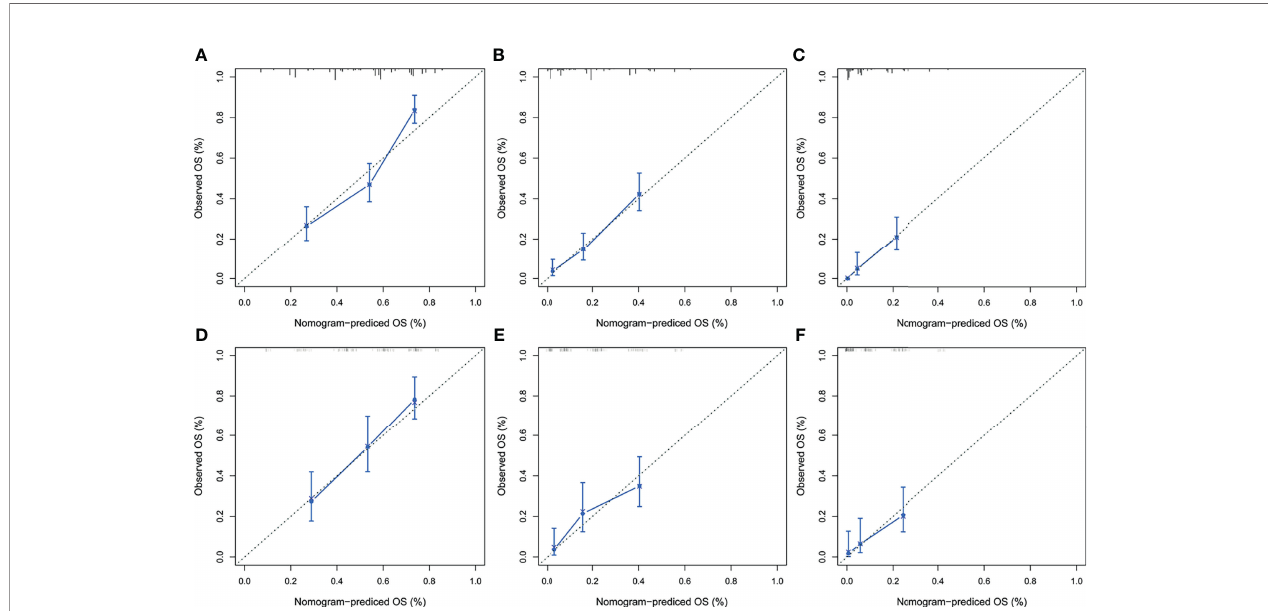
FIGURE 8 | The calibration curves of the prognostic nomogram for predicting 1-year (A) , 3-year (B) , and 5-year (C) OS in the training set. Calibration curves of the prognostic nomogram for predicting 1-year (D) , 3-year (E) , and 5-year (F) OS in the validation set. ROC, receiver operating curve; OS, overall survival.